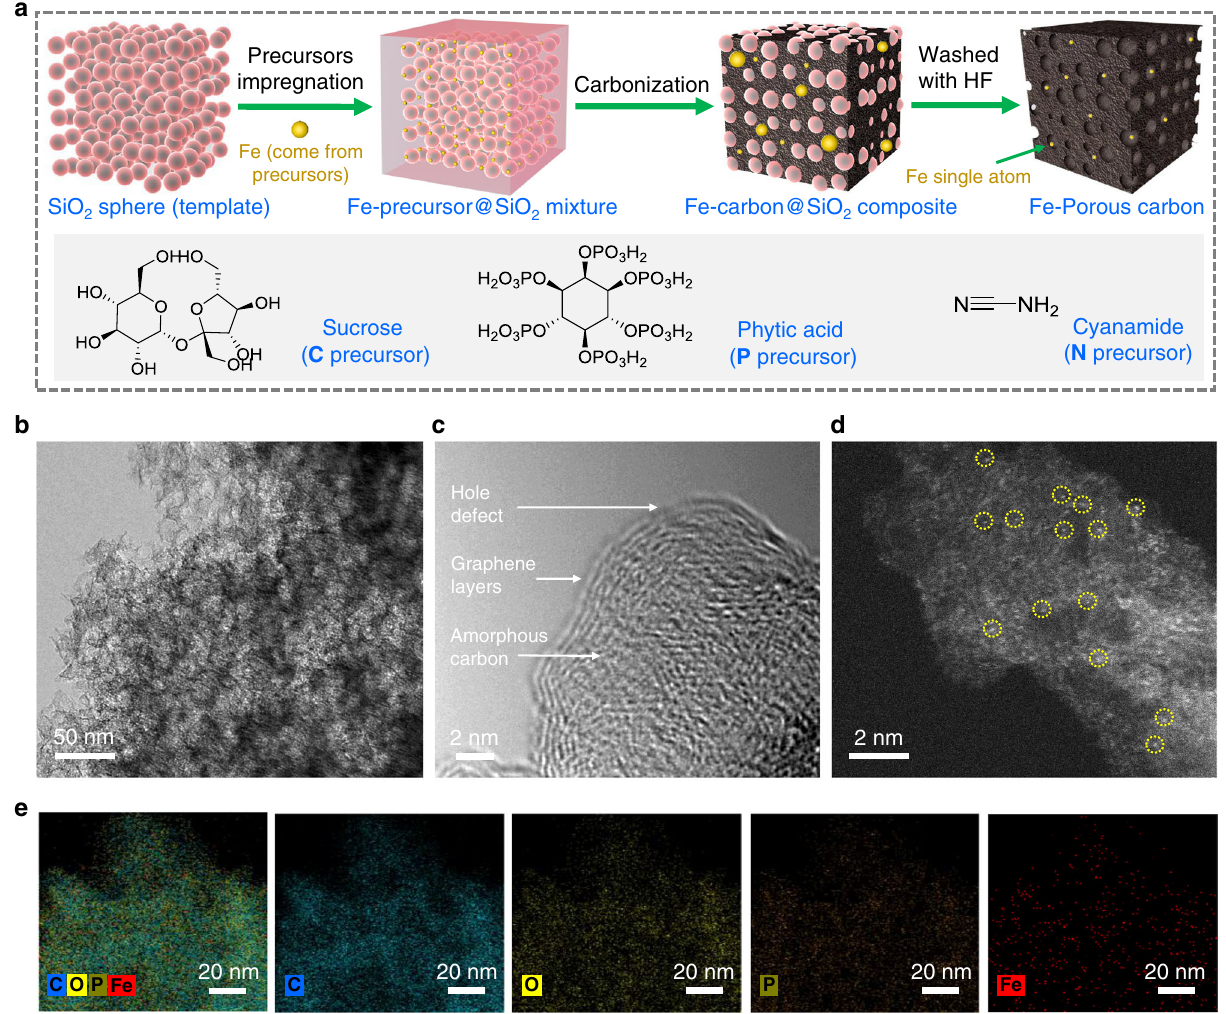
Fig. 1 Structure characterizations of Fe-P 900 -PCC. a Schematic illustration of the preparation process of PCCs. b TEM image. c HRTEM image. d AC- STEM image, Fe single atoms are highlighted by yellow circles. e EDS mapping images for various